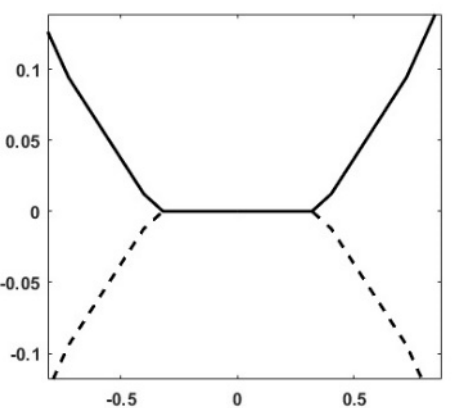
Figure 18. Close-up to the contact area between two bodies analyzed with the IGA-BEM and the optimization proposed.